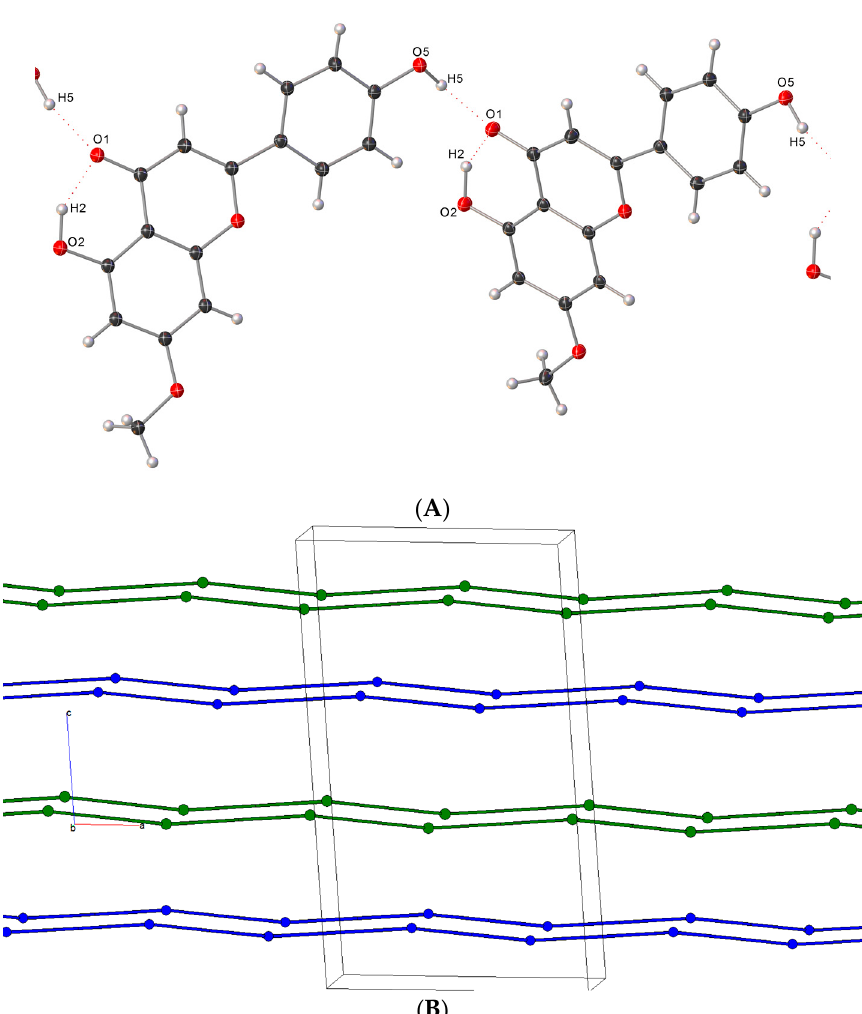
Figure 3. ( A ) A subnet consisting of an infinite, one-dimensional chains of Genkwanin molecules bridged by hydrogen bonds O2–H2···O1_1 (1.76 Å ( a ) and 1.80 Å ( b )). ( B ) The chains follow the a -axis. bridged by hydrogen bonds O2–H2 ··· O1_1 (1.76 Å ( a ) and 1.80 Å ( b )). ( B ) The chains follow the a -axis.